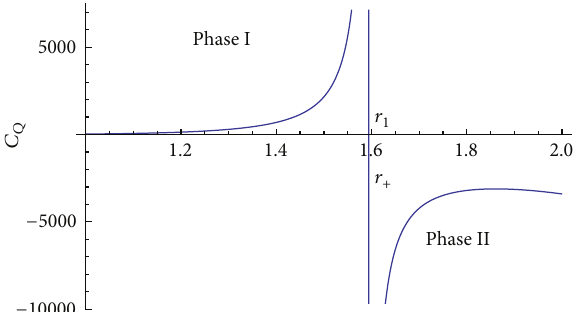
Figure 4: Plot of specific heat ( 𝐶 𝑄 ) against horizon radius ( 𝑟 + ), for 𝛼 󸀠 = 0.5 , 𝑄 = 15 , and 𝑏 = 0.60 at the critical point 𝑟 1 .